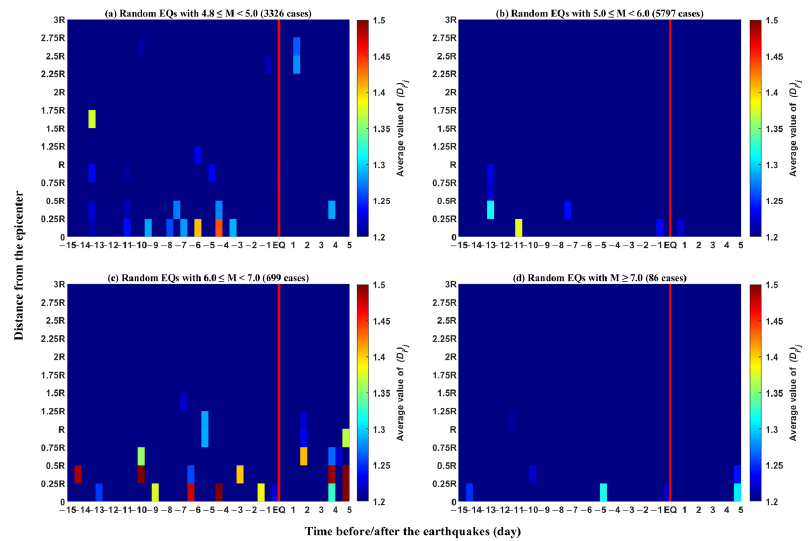
Figure 6. Same as in Figure 5 but for pseudorandom earthquakes, including EQs with M ≥ 4.8 and M < 5 ( a ), EQs with M ≥ 5 and M < 6 ( b ), EQs with M ≥ 6 and M < 7 ( c ), and EQs with M ≥ 7 ( d ).